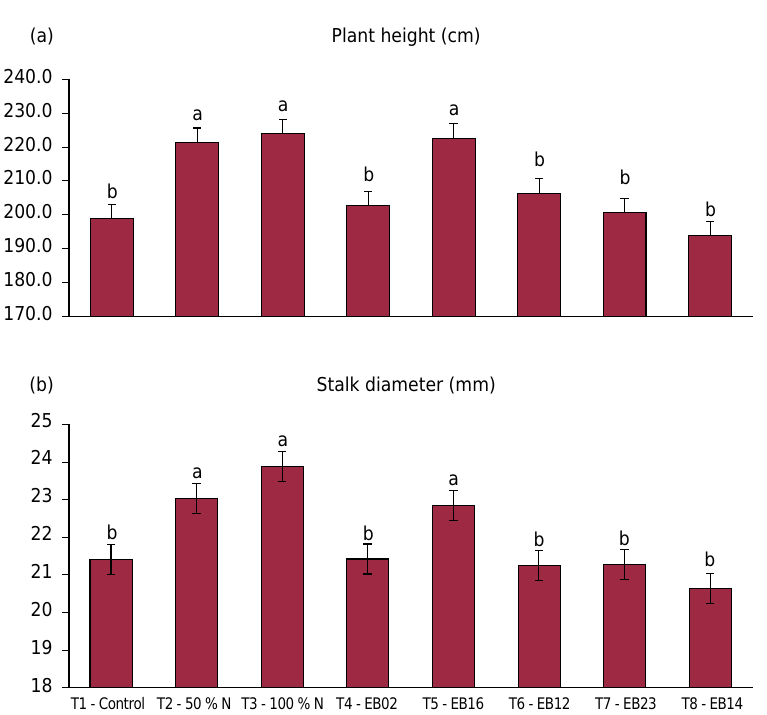
Figure 1. Bacillus sp. isolates effect on corn height (a) and stalk diameter (b). Average followed by the same letters does not differ by the Scott Knott test at 5 %.